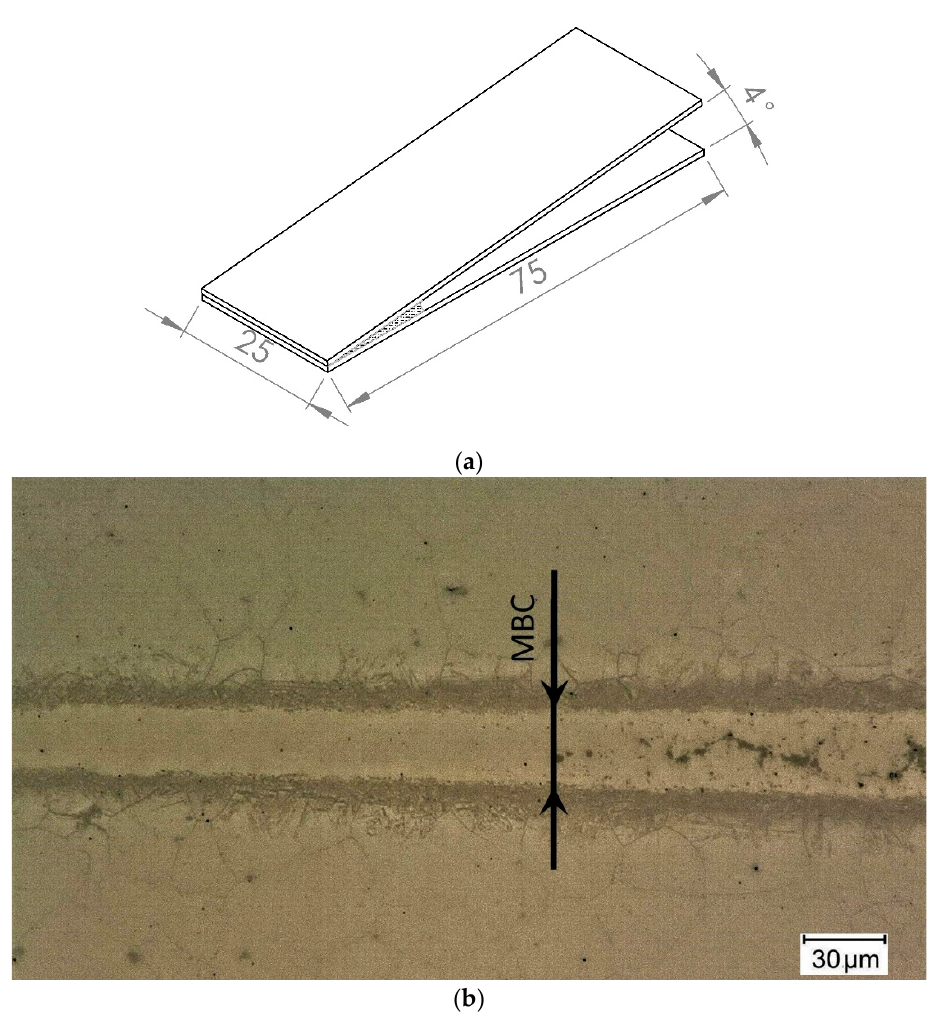
Figure 2. The wedge gap sample: scheme of configuration ( a ) and the cross section of the joint with maximum brazing clearance marked ( b ).